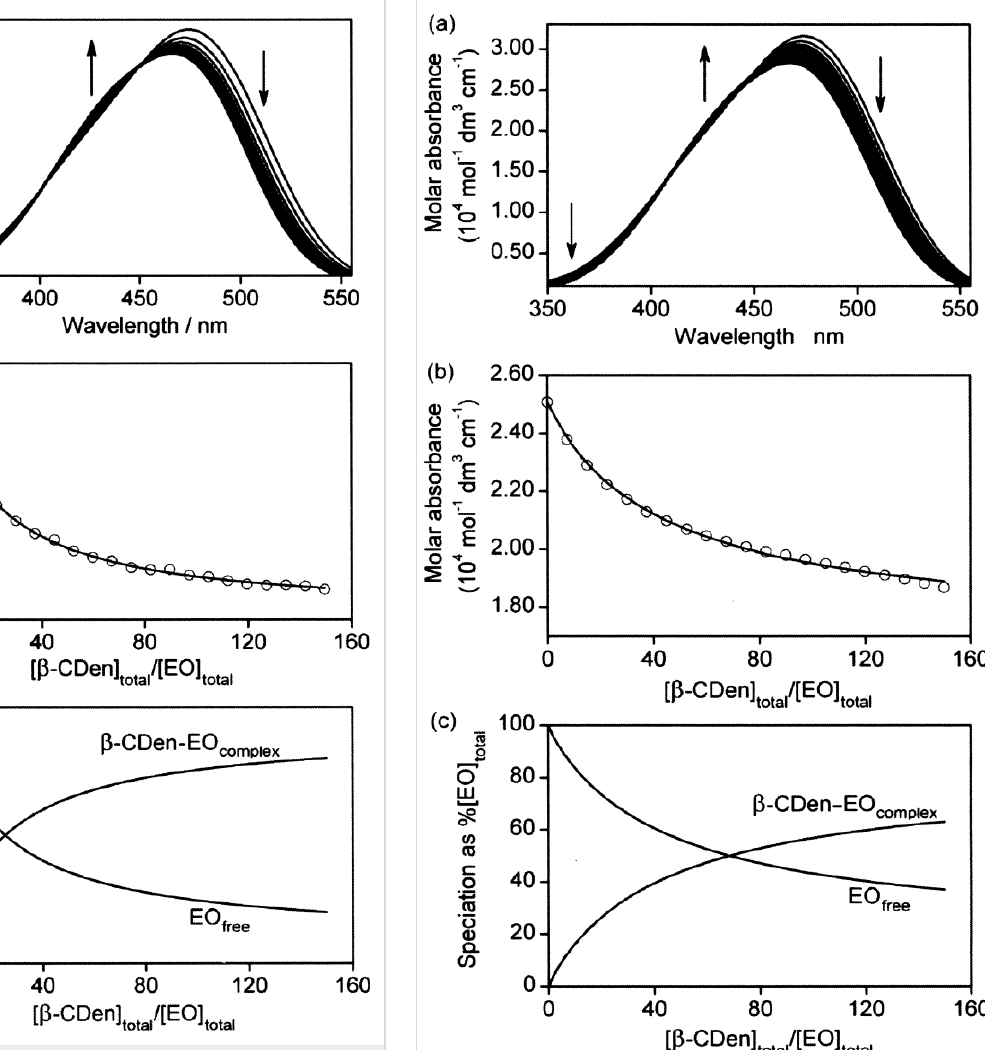
Figure 6: (a) Molar absorbance variation of 1.5 cm 3 of a EO solution ([EO] = 2.00 × 10 − 5 mol dm − 3 ) with 20 sequential additions of a PAA β - CDen solution (50 mm 3 each, 0.98 wt %, [ β -CDen] = 4.49 × 10 − 3 mol dm − 3 ) at 298.2 K. Both solutions were prepared in aqueous Na 2 HPO 4 /KH 2 PO 4 buffer at pH 7.0 and I = 0.10 mol dm − 3 . The arrows indicate the direction of molar absorbance variation upon each addition of PAA β -CDen solution. (b) Molar absorbance variation at 500 nm and the line representing the best fit of an algorithm for a 1:1 host–guest complexation of EO by β -CDen substituents of PAA β - CDen over the wavelength range 475–525 nm. (c) Speciation plot with [EO] total = 100% as the ratio [ β -CDen] total /[EO] total increases. The UV–vis variations observed for titration of the dyes with PAA β -CDen and PAAADen, PAAADhn, or PAAADddn, as exemplified by the ternary PAA β -CDen/PAAADhn/EO system (Figure 7), reflect the competition between the dye and the adamantyl substituent groups (and also the dodecyl tether for PAAADddn) and the dye for complexation by the β -CDen sub- stituents of PAA β -CDen, as do the derived K 11 (Table 2). Thus, there are two competing equilibria for complexation by the β -CDen substituent in the PAA β -CDen/PAAADhn network as